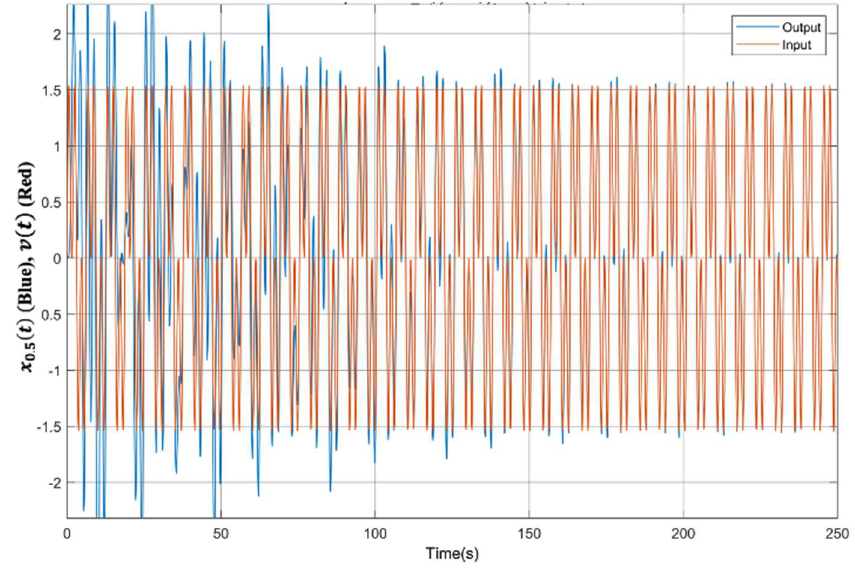
Fractal Fract. 2023 , 7 , 50 Figure 6. Response to the Periodic Input 𝒗(𝒕) = 𝐬𝐢𝐧𝒕 + 𝐬𝐢𝐧𝟑𝒕 in the 𝒑 -plane. Figure 6. Response to the Periodic Input v ( t ) = sin t + sin3 t in the p -plane.